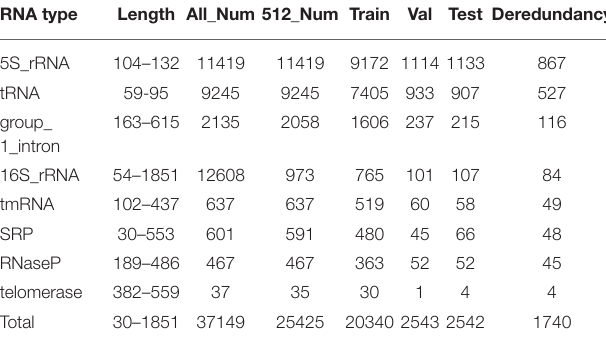
specific distribution is exhibited in Table 2 . In this experiment, TABLE 2 | RNAStralign dataset